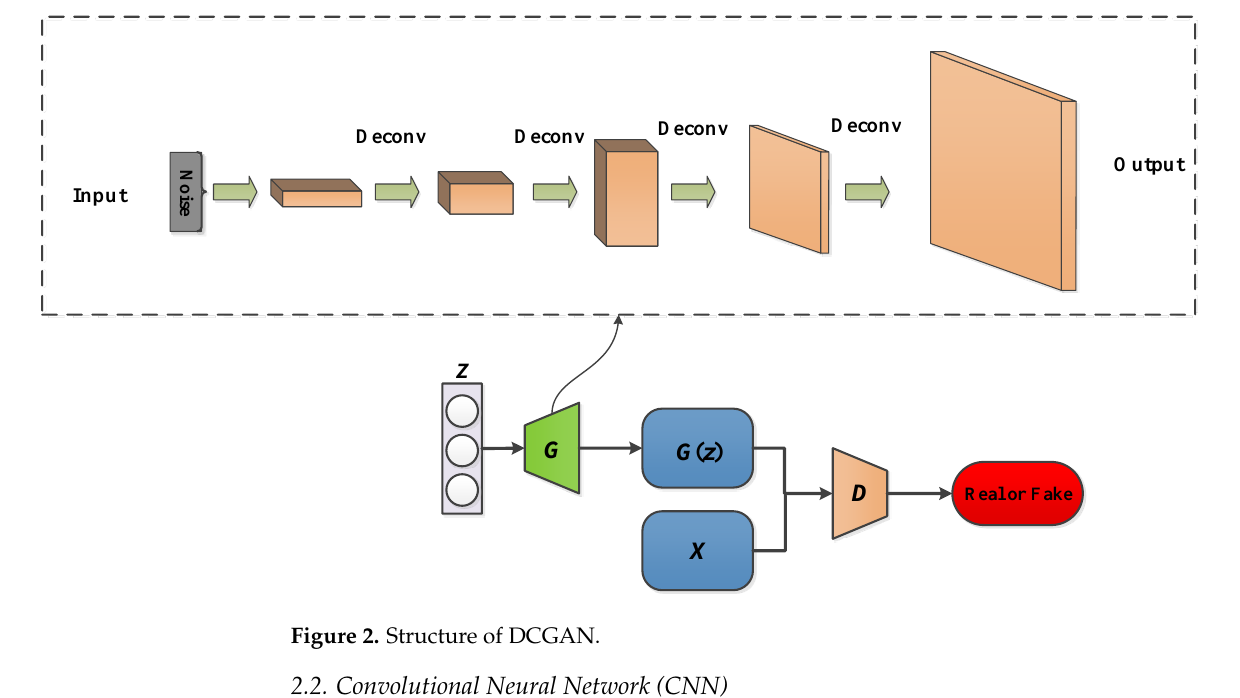
Figure 2. Structure of